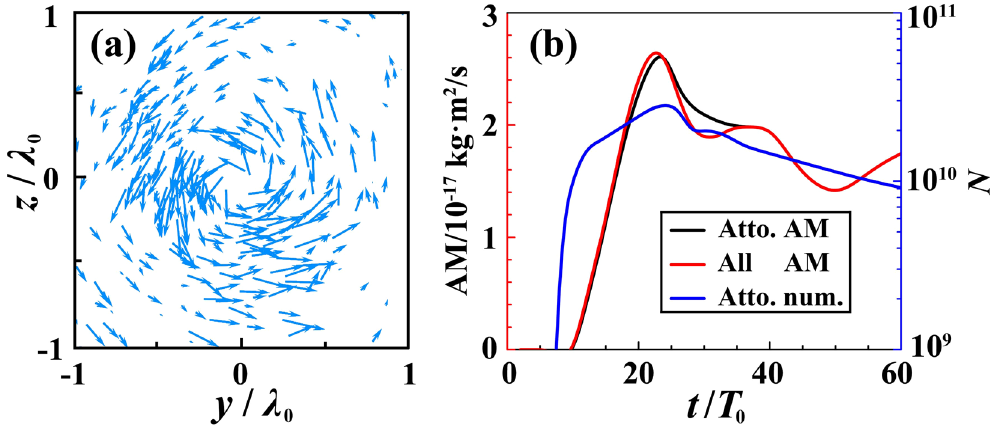
Figure 4. Electron velocity field with AM larger than 2.73 × 10 − 28 kg ⋅ m 2 /s in the yz plane with x = 44.1 λ 0 at t = 50 T 0 ( a ). Temporal evolution of the electron BAM and charge ( b